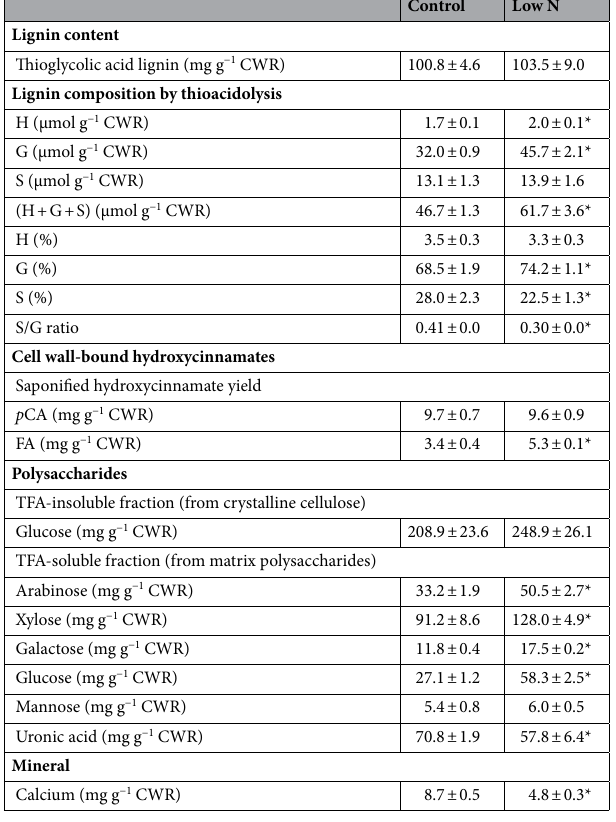
Table 1. Cell wall chemical analysis of hydroponically-grown sorghum seedlings cultivated under control and low-N conditions at 3 weeks after treatment. Asterisks indicate significant differences between low-N and control plants (Student’s t test, p < 0.05). CWR: cell wall residue, H: p -hydroxyphenyl, G: guaiacyl, S: syringyl, p CA: p -coumarate, and FA: ferulate, TFA: trifluoroacetic acid. Values are means ± SD (n =